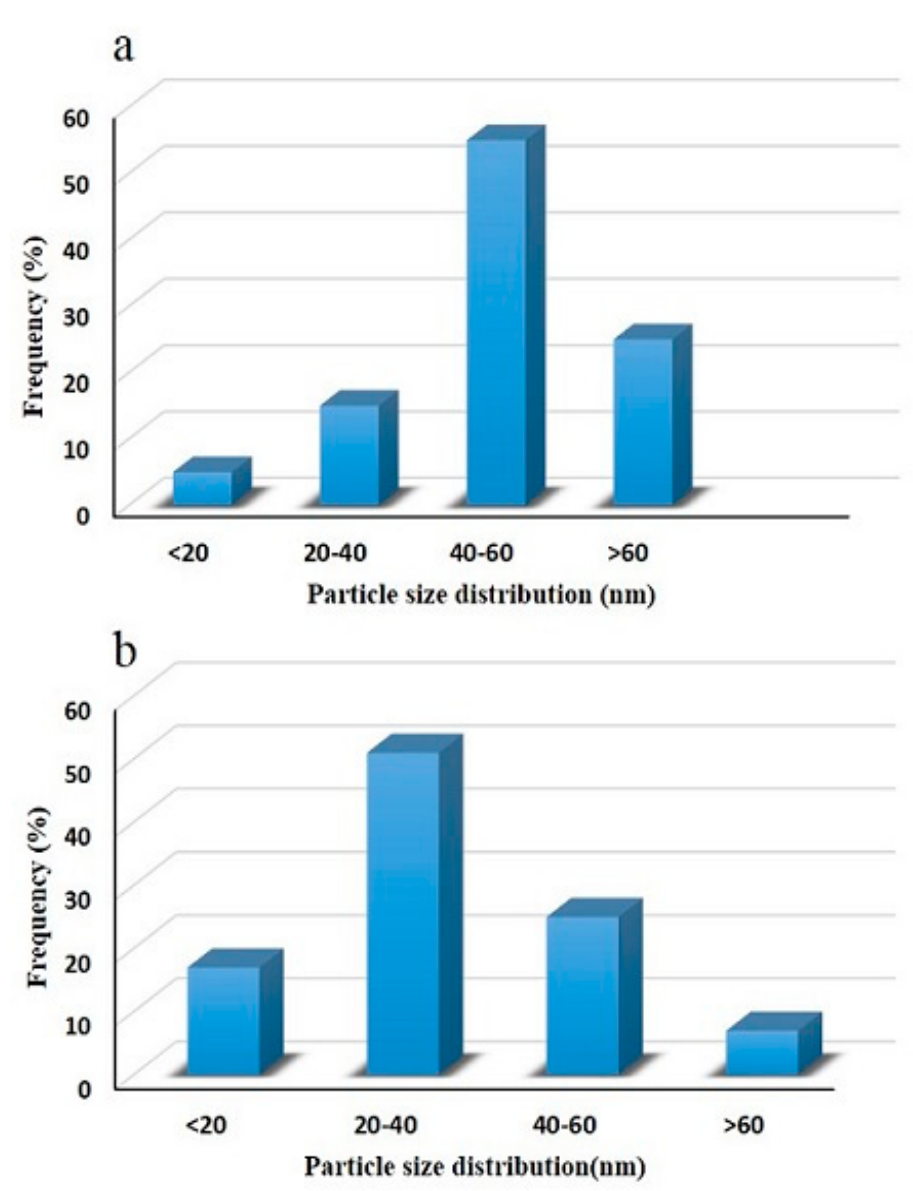
Figure 4. The size distribution of ( a ) undoped CdSe and ( b ) 8% Tb-doped CdSe nanoparticles. XPS analysis was carried out to prove the Tb ions incorporation into the CdSe crystal lattice and to evaluate the oxidation state of terbium. The narrow scan XPS and XPS spectrum of Tb 0.08 Cd 0.92 Se nanoparticles are shown in Figure 5a–d. The narrow scan spectra of Cd 3d in Figure 5b shows two peaks centered at 412 and 405 eV, which can be associated with the transition of respectively Cd 3d3/2 and Cd 3d5/2 [30]. The single peak placed at a binding energy of 54.58 eV is associated with the Se 3d transition (see Figure 5c) [31]. As shown in Figure 5d, the Tb 3d5/2 and 3d3/2 peaks placed at 1276.49 and 1243.56 eV confirm that Tb ions were doped successfully into the CdSe’s crystal lattice [33]. The UV–VIS diffuse reflectance spectrum was used to study the optical absorption property, as shown in Figure 6. To quantify the shift of the absorption edge, the band-gap energies of Tb-doped CdSe and pure CdSe were calculated by Tauc’s